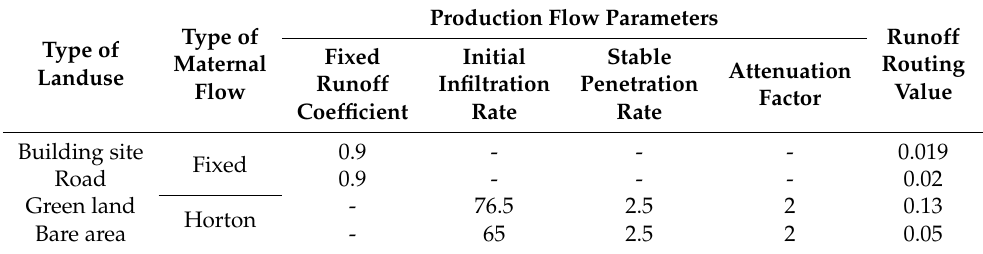
Table 1. Model production sink